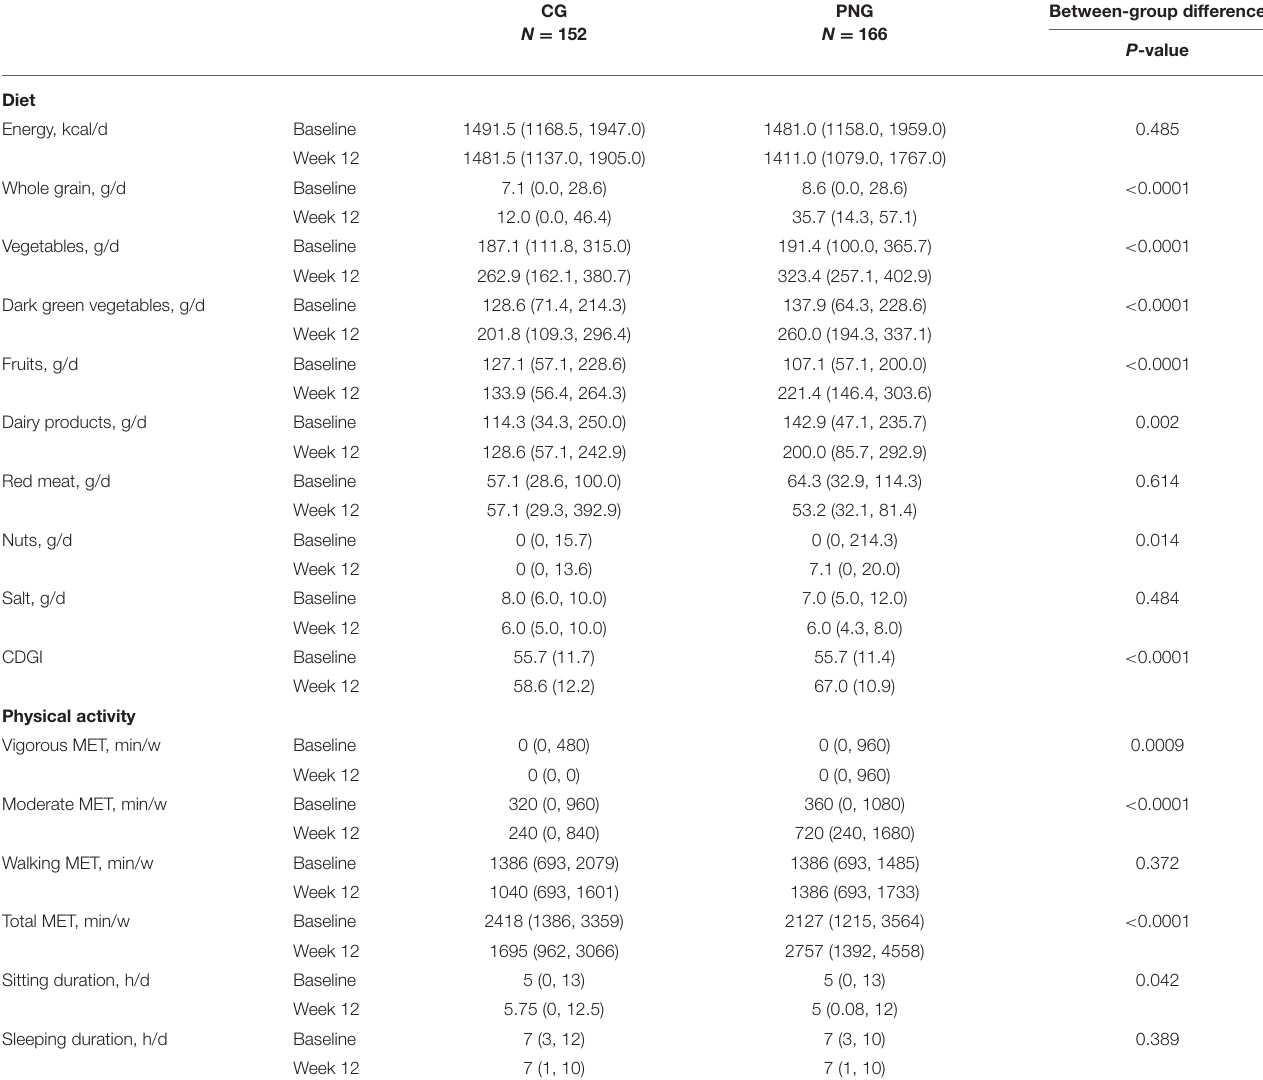
TABLE 3 | Dietary intake and physical activity at baseline and week 12 in both